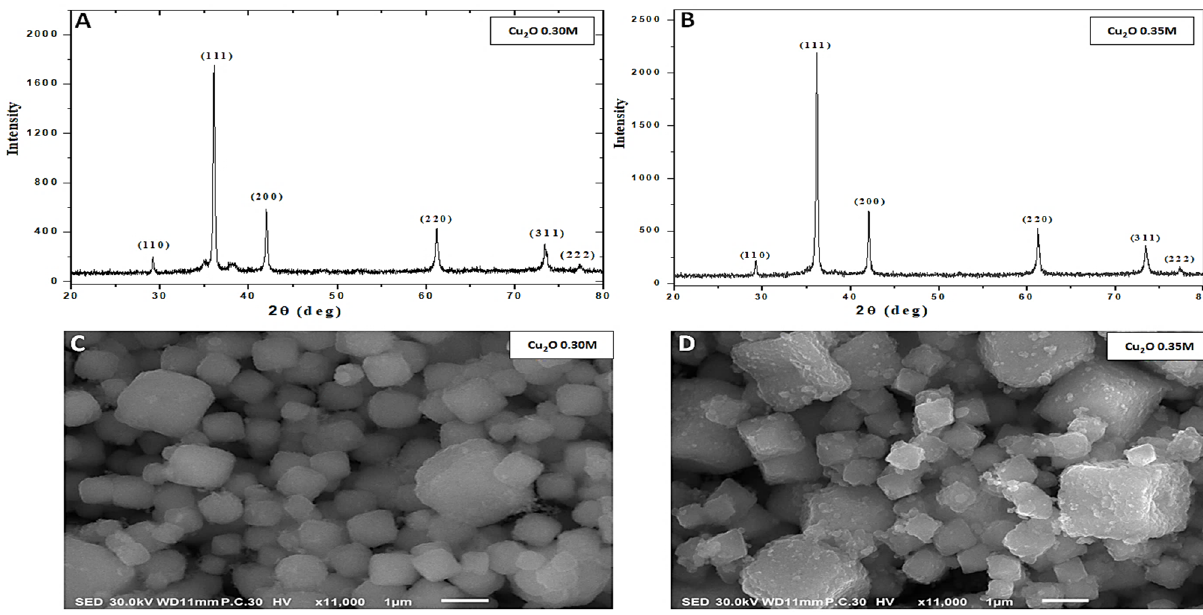
Figure 1. XRD patterns of the fabricated Cu 2 O nanoparticles ( A , B ). Top view of SEM image of surface morphologies of fabricated Cu 2 ONPs ( C , D ).